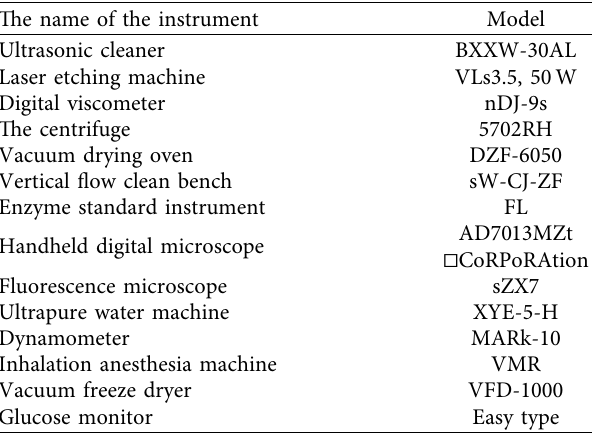
Table 2: Names and models of instruments